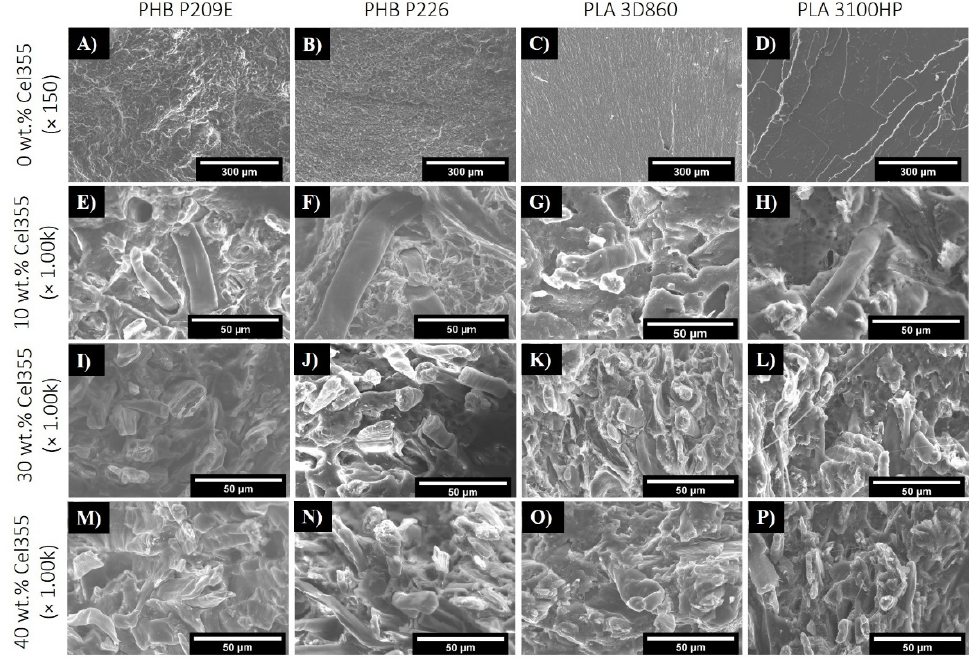
Figure 3. SEM micrographs of the fractured surfaces of ( A – D ) the neat PHB and PLA matrices